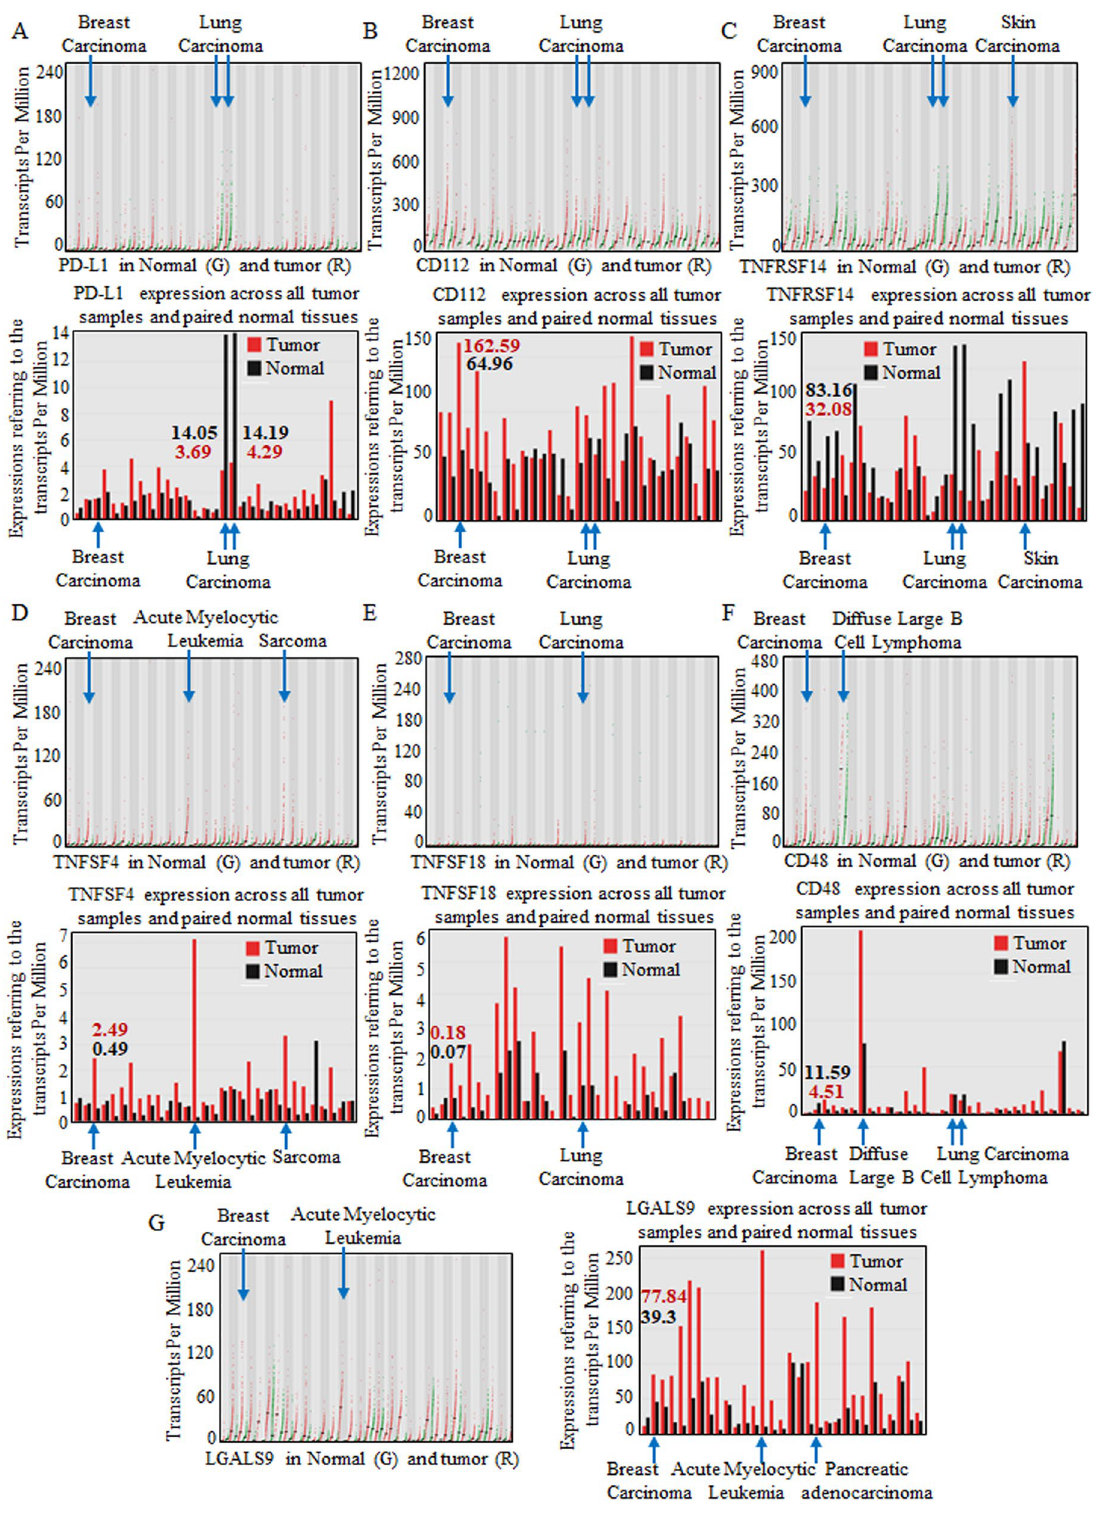
Figure 1. Analyzing candidate immune checkpoint molecules targeted by blockade in carcinomas. Carcinomas throughout the body were enrolled for analysis, and multiple systems showed various immune checkpoint molecule patterns. PD-L1 ( A ), CD112 ( B ), TNFRSF14 ( C ), TNFSF4 ( D ), TNFSF18 ( E ), CD48 ( F ), and LGALS9 ( G ) were analyzed for abnormal expression in breast carcinomas. In each image, the specific quantitative value is shown at the top, and each dot represents the expression in samples. The bar graphs below were used for comparison, and bar height bar represents the median expression of the specific tumor type or normal tissue. Specifically, CD112, TNFSF4, TNFSF18, and LGALS9 were relatively overexpressed in breast